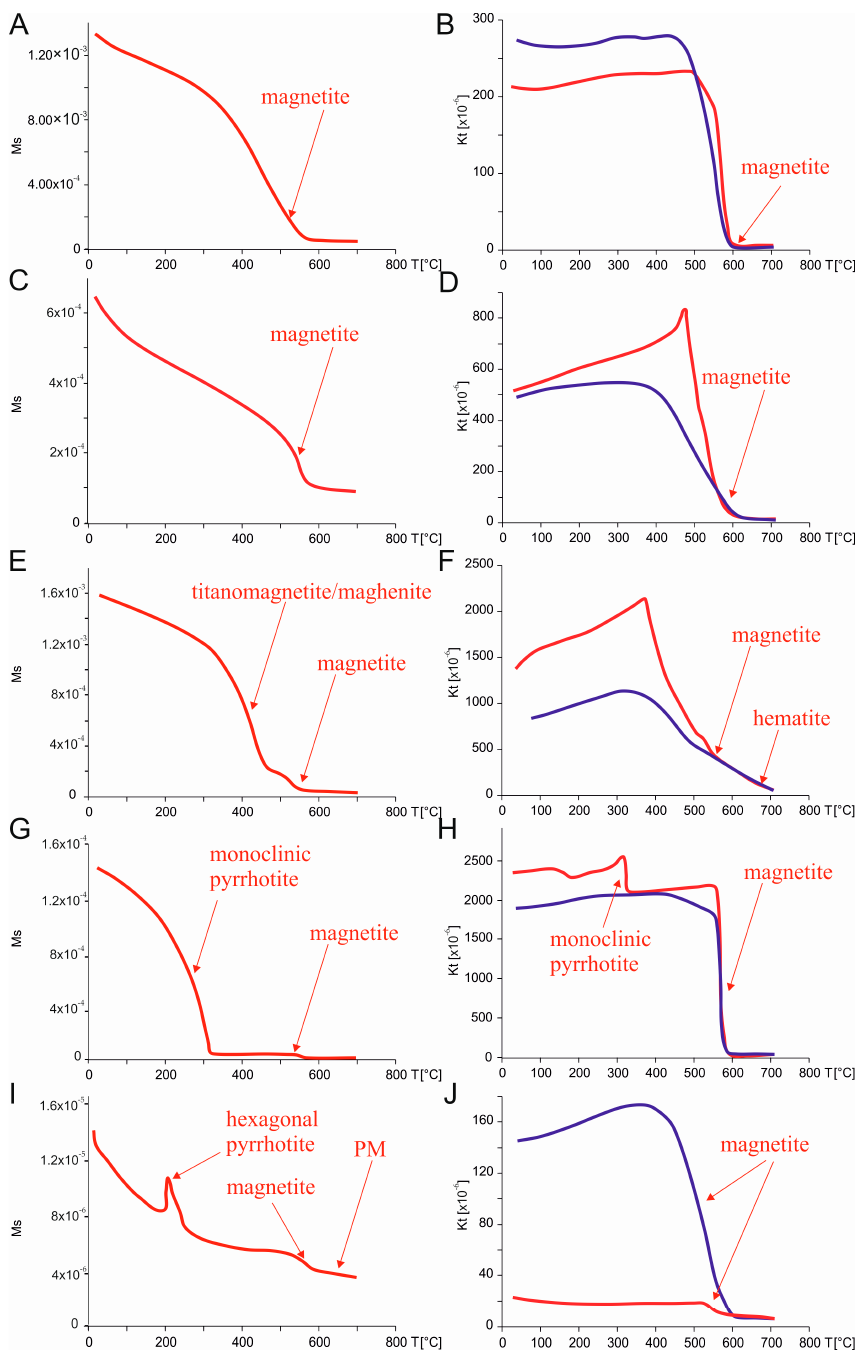
Figure 5. Representative curves of thermal dependence for the saturation magnetization ( A , C , E , G , I ) and magnetic susceptibility ( B , D , F , H , J ). Heating is shown in red, cooling in blue. ( A ) Sample 229, site mk19_19, basalts of the Mokulaevsky Formation, I-type. ( B ) Sample 160, site mk7_19, basalts of the Mokulaevsky Formation, N-type. ( C ) Sample 427, site 19_19, the Ruinnaya intrusion (Morongovsky complex), R-type. ( D ) Sample 57, site 4_17, dike of the Daldykan complex, I-type. ( E ) Sample 227, site sm12_21, basalts of the Samoedsky Formation, N-type. ( F ) Sample 18, site sm1_21, basalts of the Samoedsky Formation, R-type. ( G ) Sample × 57, site 49_17, gabbro-dolerites of the Talnakh intrusion, R-type. ( H ) Sample 696, site 26_17, Kharaelakh intrusion, R-type. ( I ) Sample × 18, site 47_17, skarns near the Talnakh intrusion, N-type. ( J ) Sample 333, site 13_16, Kruglogorsky intrusion,